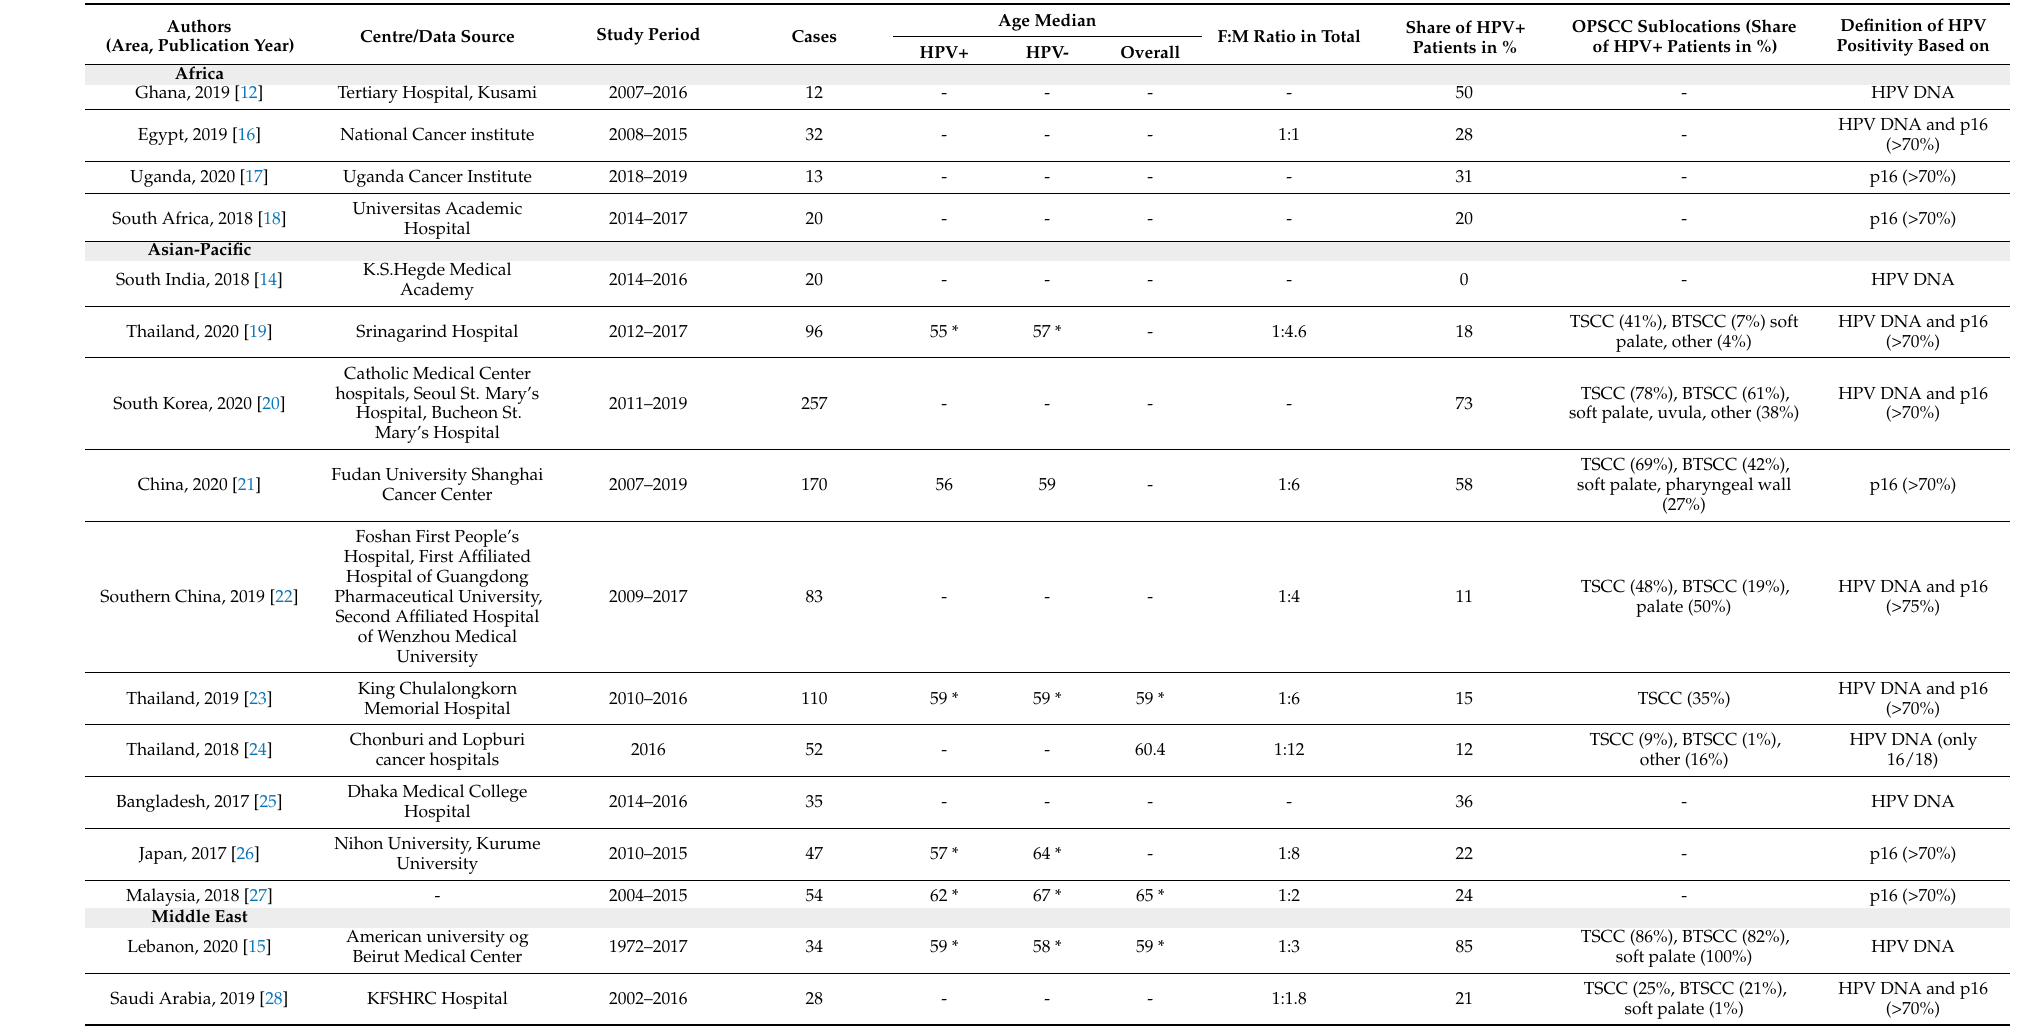
Table 1. HPV-positivity in OPSCC among patients